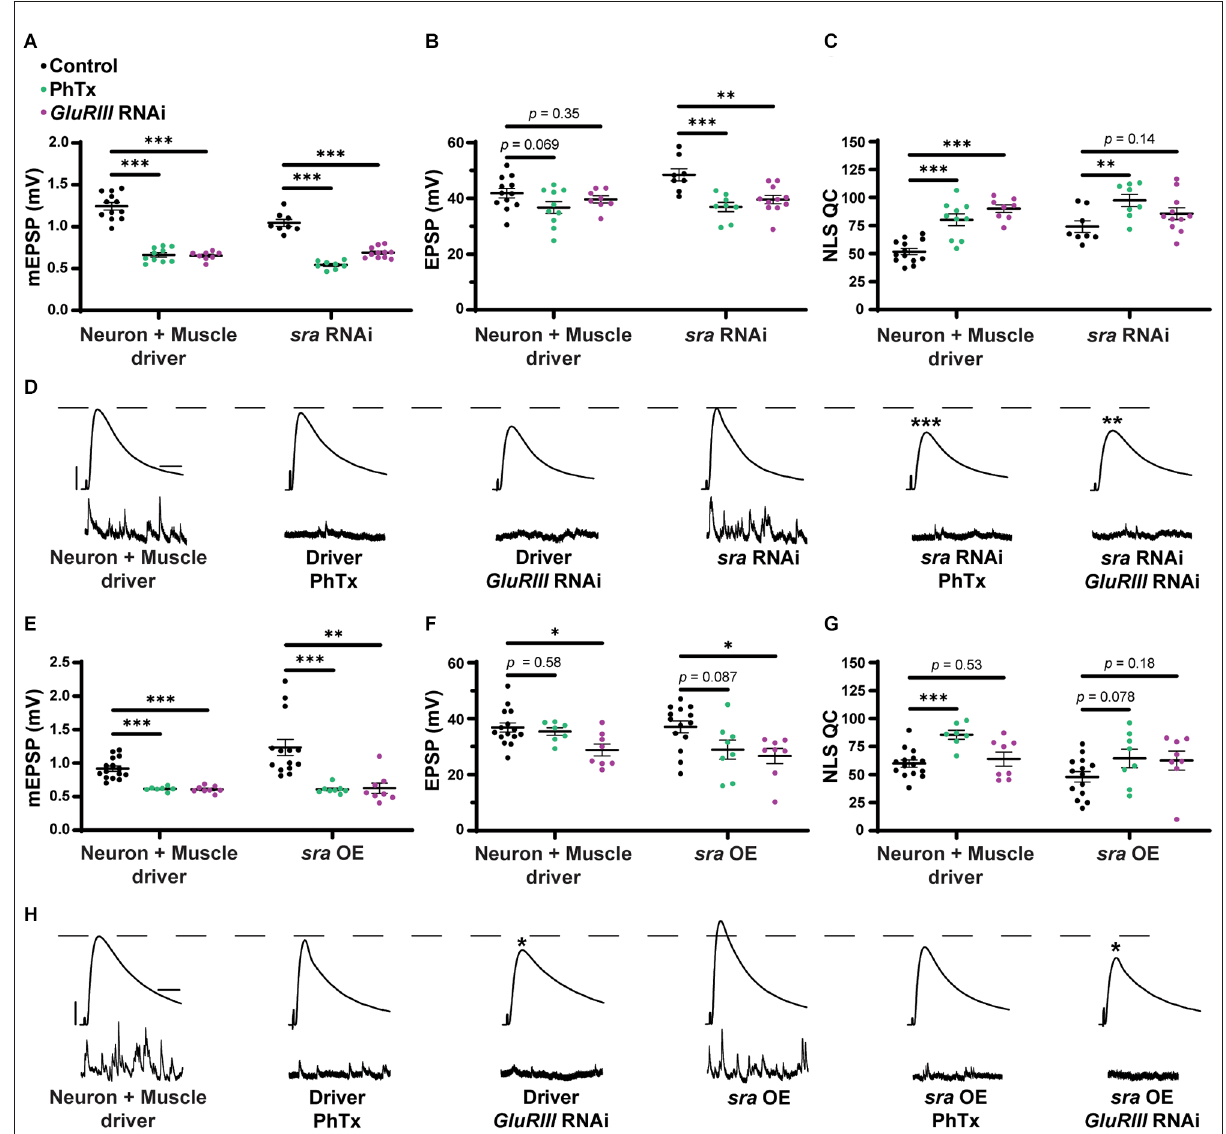
FIGURE1 Dual pre and postsynaptic knockdown or overexpression of sra do not block PHP. (A–C) Quantification showing average mEPSP amplitude, EPSP amplitude, and NLS quantal content in pre + post-GAL4 control and pre + post-GAL4 driven sra RNAi . Black points show DMSO control synapses, green points show synapses treated with PhTx, and magenta points show animals chronically challenged with GluRIII RNAi . (D,H) Representative electrophysiological traces of EPSPs (above) and mEPSPs (below). Scale bars for all traces are y = 10 mV (1 mV), x = 20 ms (500 ms) for